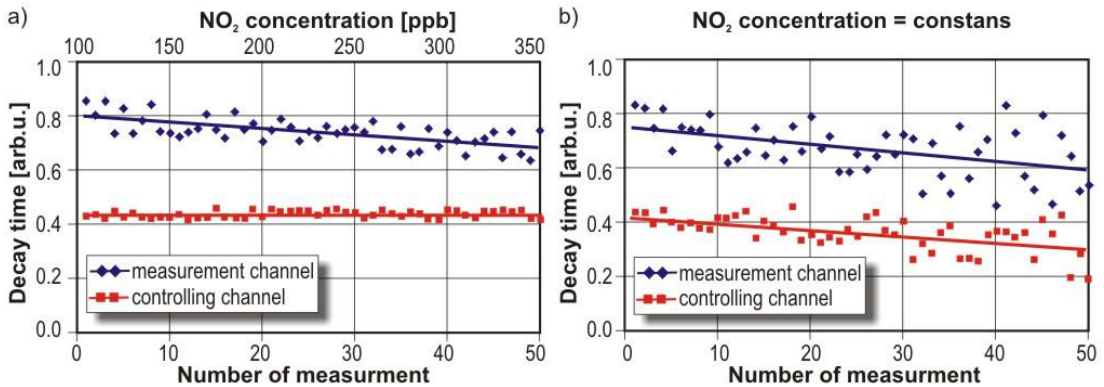
concentrations measurements ( a ); 2 ( b ). 2